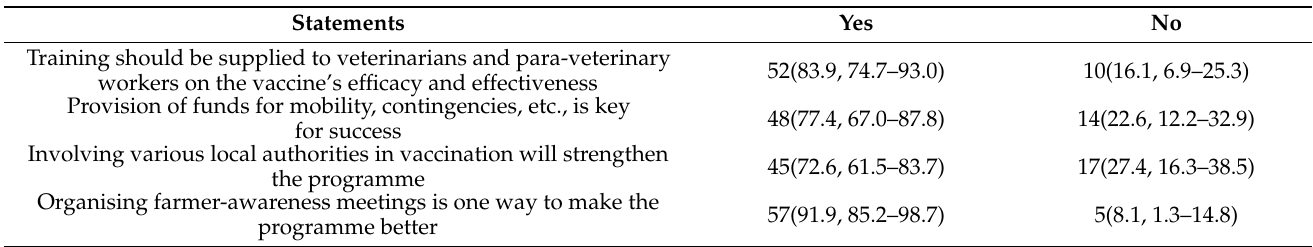
Table 6. Opinions of veterinarians regarding statements for the improved implementation of PPR-CP in Karnataka ( n =